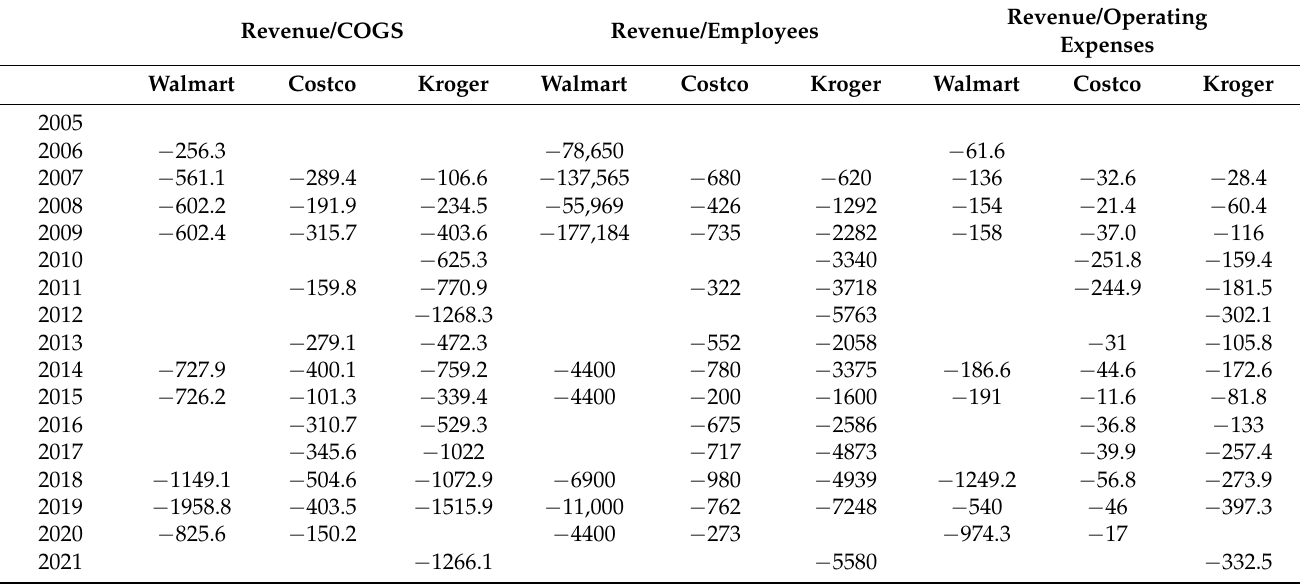
Table 10. Suggested improvements of input resources for inefficient